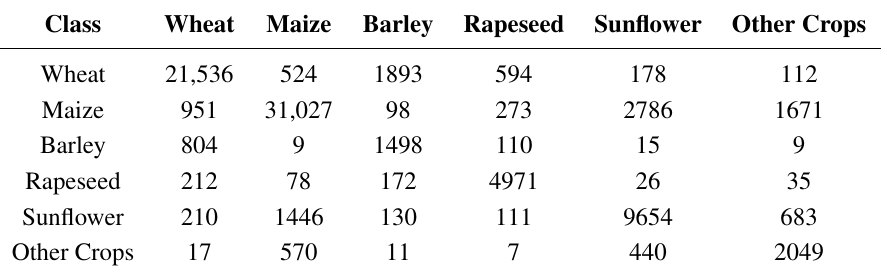
Table 4. Confusion matrix for SVM on the France test site.